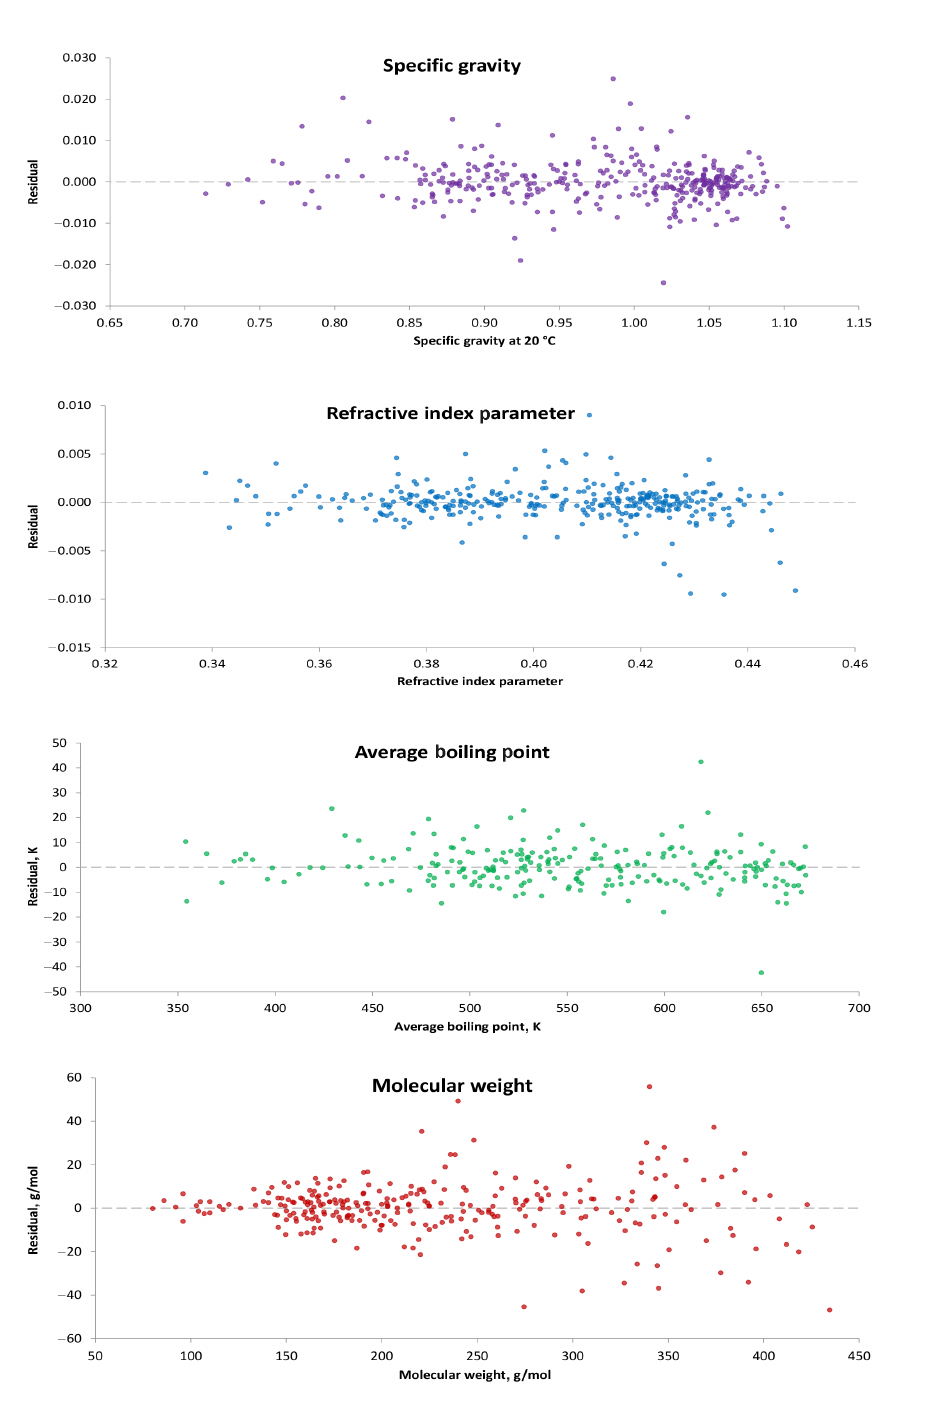
Fig. 1. Residuals of the predicted values for samples as part of the cross validation